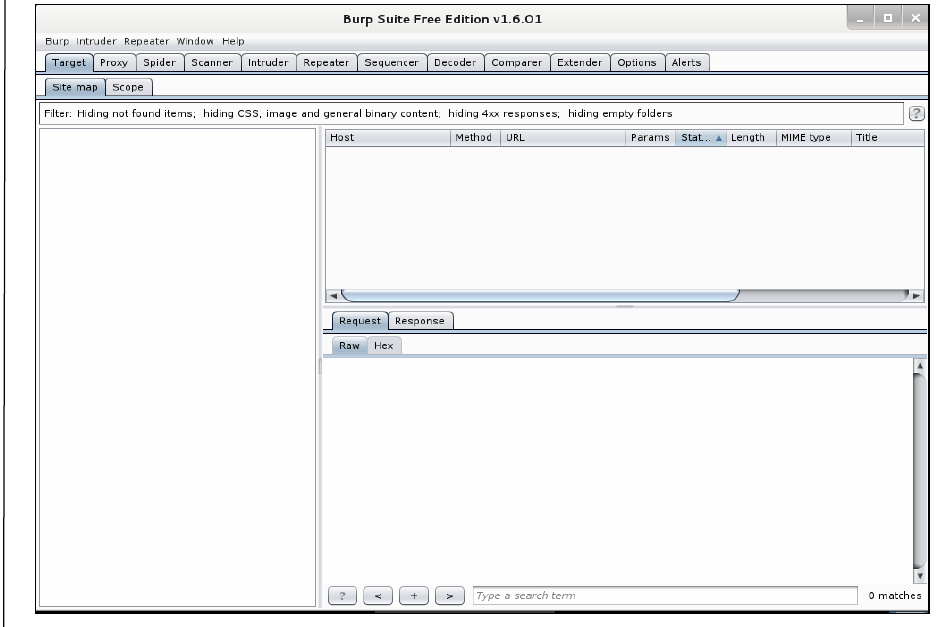
Figure 2 – Burp Suite – initial screen Рис . 2 – Burp Suite – начальный